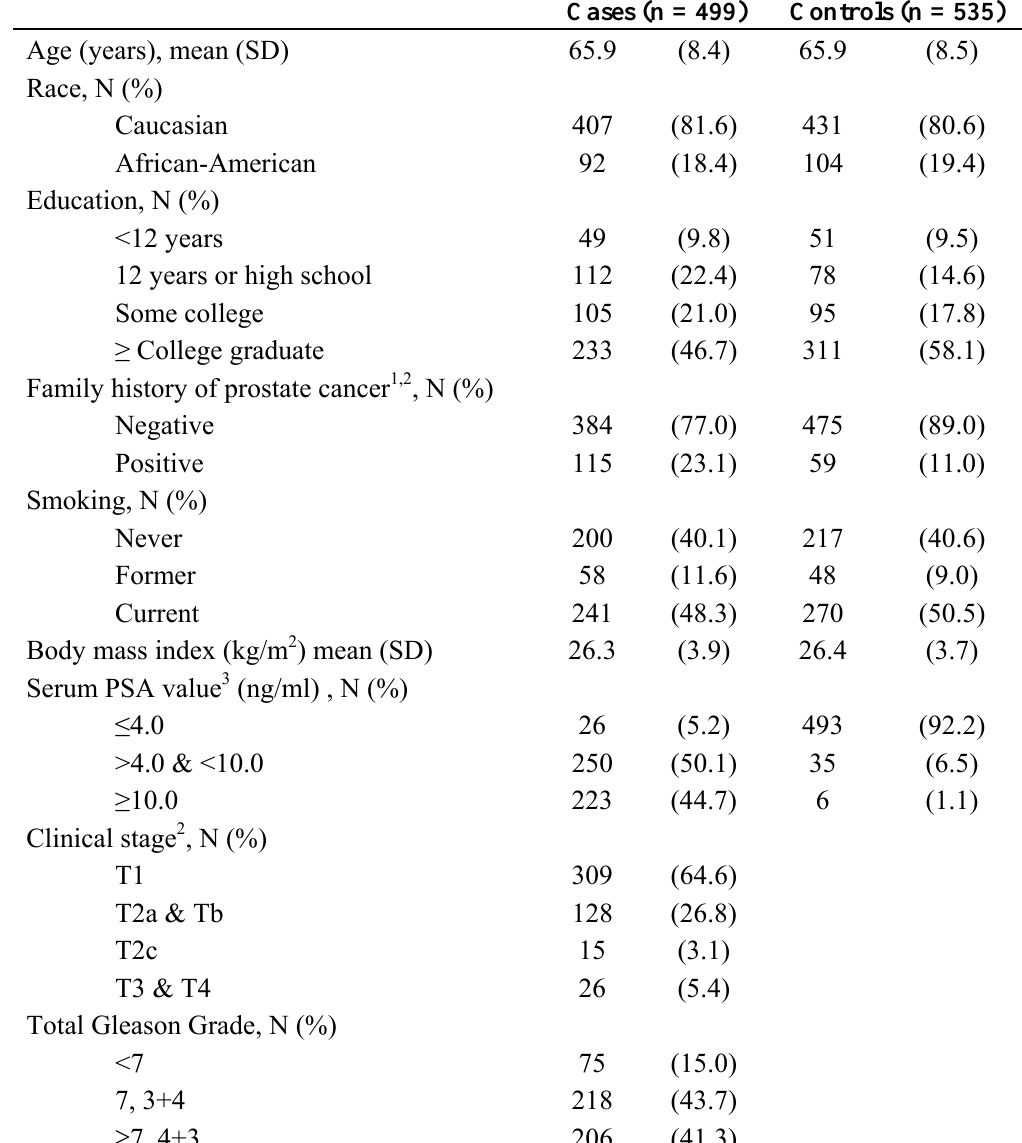
Table 1. Characteristics of study population (advanced /aggressive prostate cancer cases and